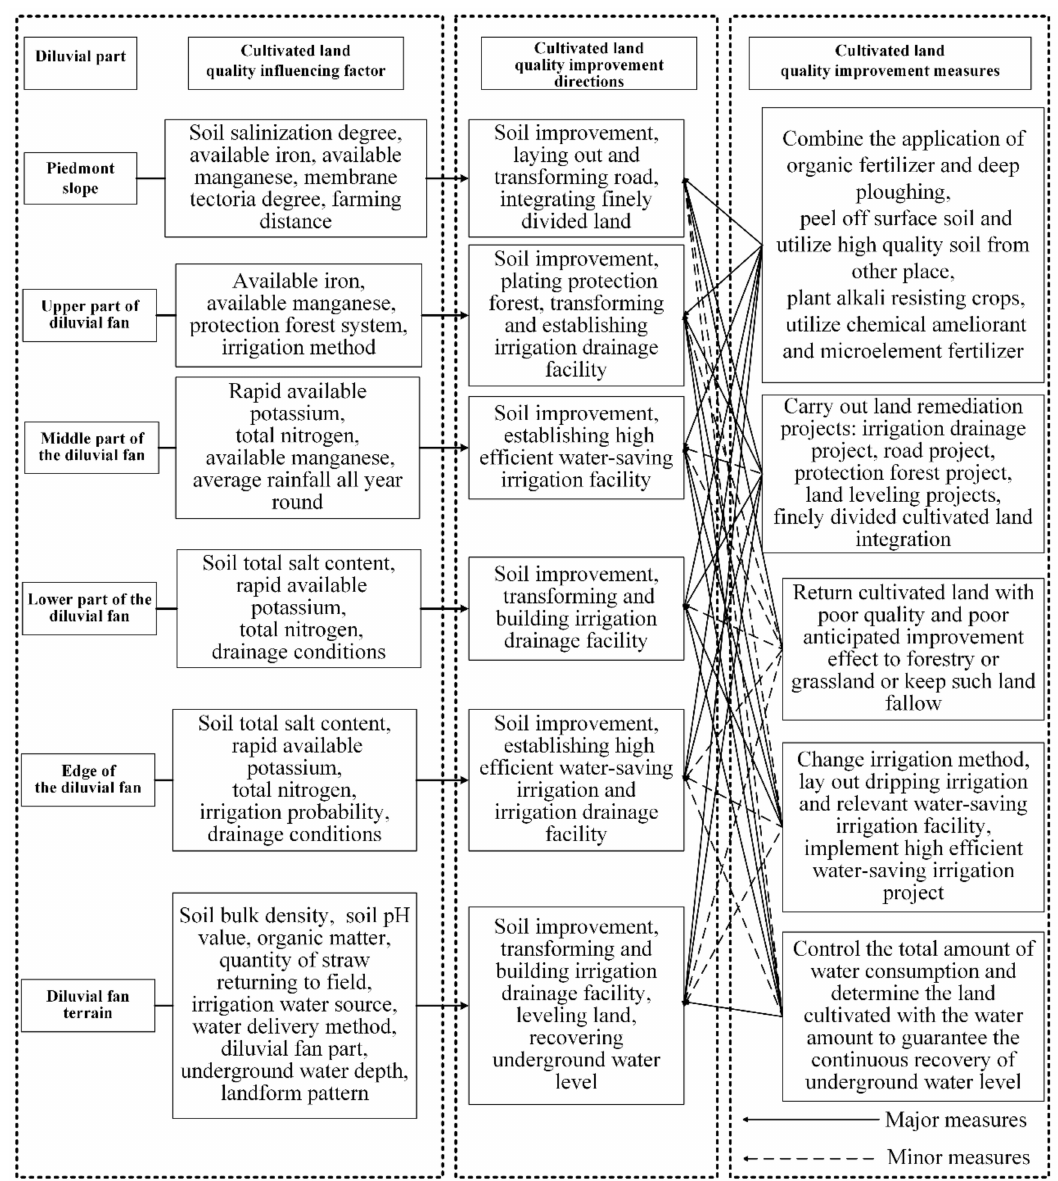
Figure 14. Cultivated land quality improvement directions and